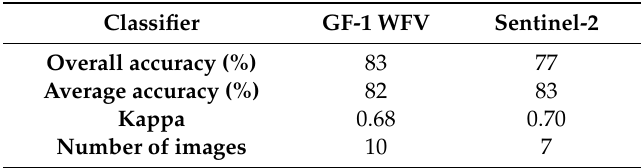
Table 4. Accuracy comparison of the GF- WFV and Sentinel-2